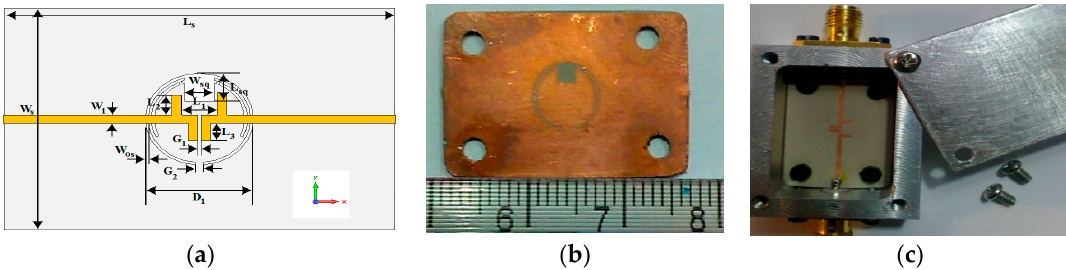
Figure 10. ( a ) Schematics and geometrical diagram of the SCSRR based bandpass filter; ( b ) Back-side of the fabricated bandpass filter; ( c ) Front-side of the fabricated bandpass filter.